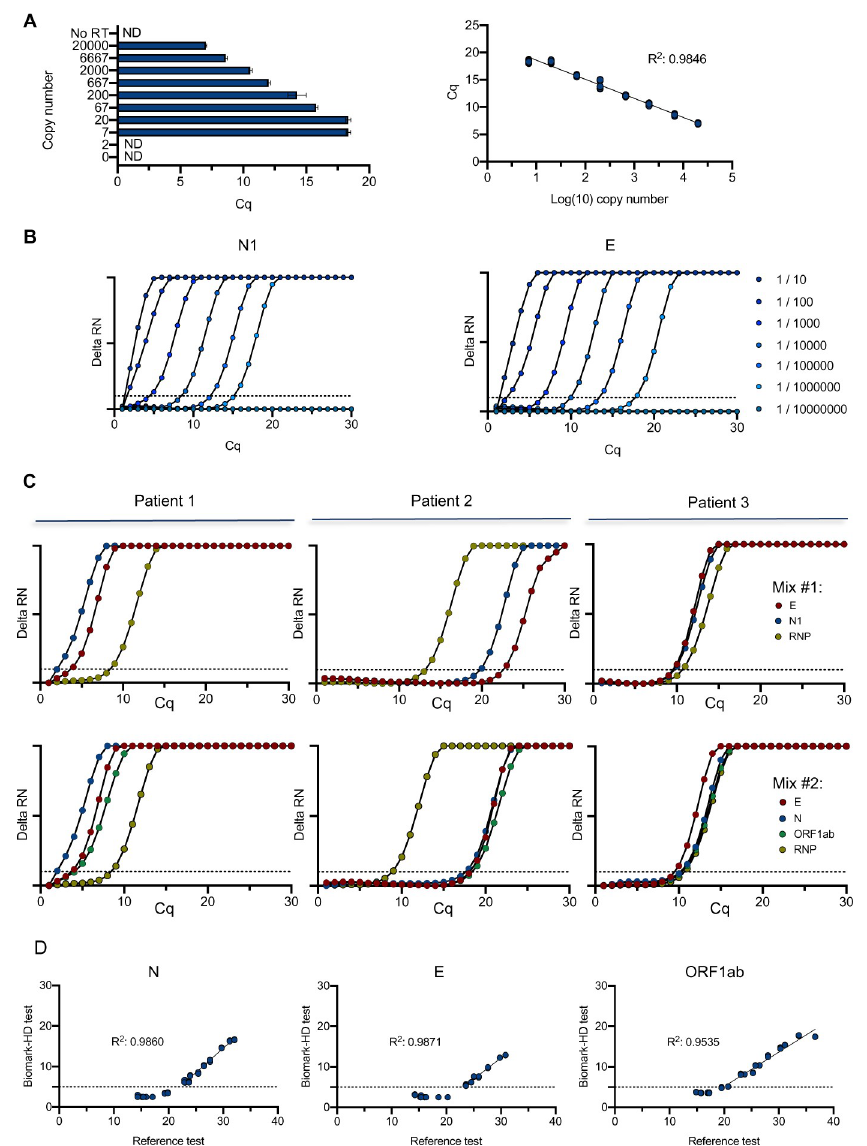
Fig 1. Performance and validation of the Biomark-HD SARS-CoV-2 qPCR assay. (A) Titration of the diluted (N) nucleocapside spike-in transcript. A serial dilution of the synthetic N transcript from 2.10 4 to 2 copies was performed and processed through the Biomark-HD protocol. Correlation and amplification curves of detected Cq values according to synthetic N transcript copy number obtained with N1 primers/probe are shown. (B) Amplification curves showing the range of detection of a SARS-CoV-2 positive clinical sample serial dilution with N1 and E primers/probe. (C) Typical amplification curves showing the combination of two primers/probe sets on 3 SARS-CoV-2 positive clinical samples. Mix #1: E, N1, human RNP. Mix #2: E, N, ORF1ab and human RNP. (D) Validation of the Biomark- HD protocol on a cohort of 18 biopsies from positive patients. The correlation of the Cq values obtained for the N, E and the ORF1ab genes are presented. The data presented are representative of at least two independent experiments performed in quadruplicate. Cq values. Very similar Cq values were obtained with both methods for the cellular (RNP) and for 2 viral (E and N) primers/probe sets. The detection limit for ORF1ab gene was even improved using the Cells Direct One-Step qRT-PCR kit-based protocol (Fig 2A). Overall, this protocol offers the possibility to run 192 samples with 24 couples of primers/probe sets (using the Fluidigm 192.24 IFC) corresponding to 4608 end-points in less than 3 hours.